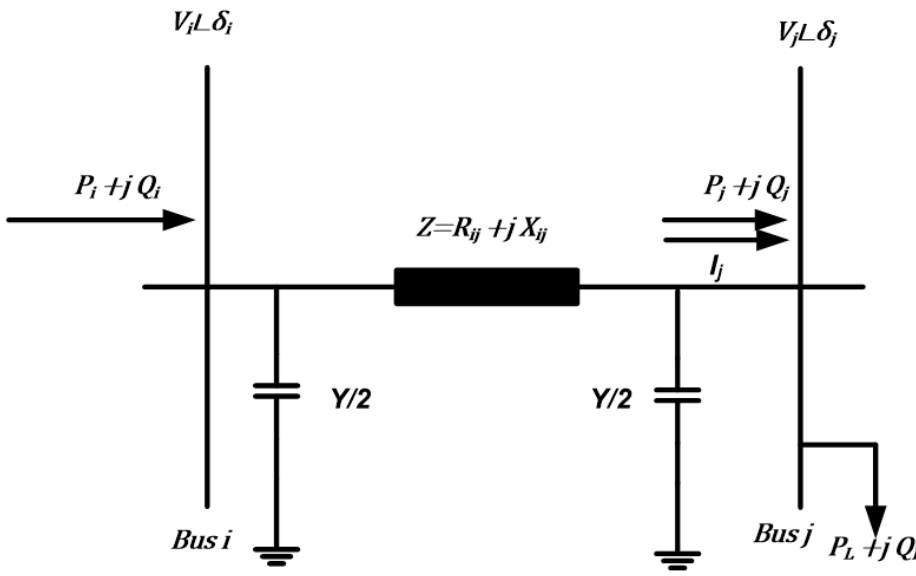
Figure 3. Two-bus